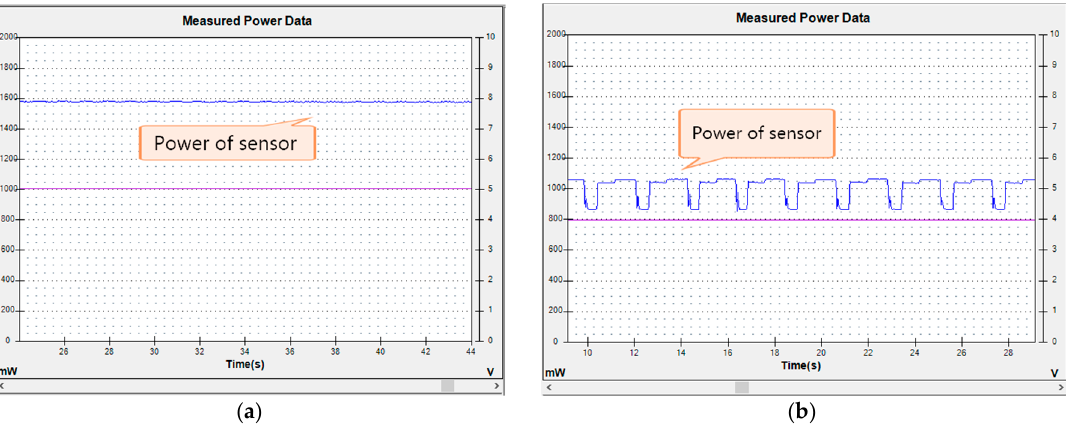
Figure 7. Sensor system power. ( a ) Sensor power sampled every 0.02 s; ( b ) Sensor power sampled every 0.04 s.